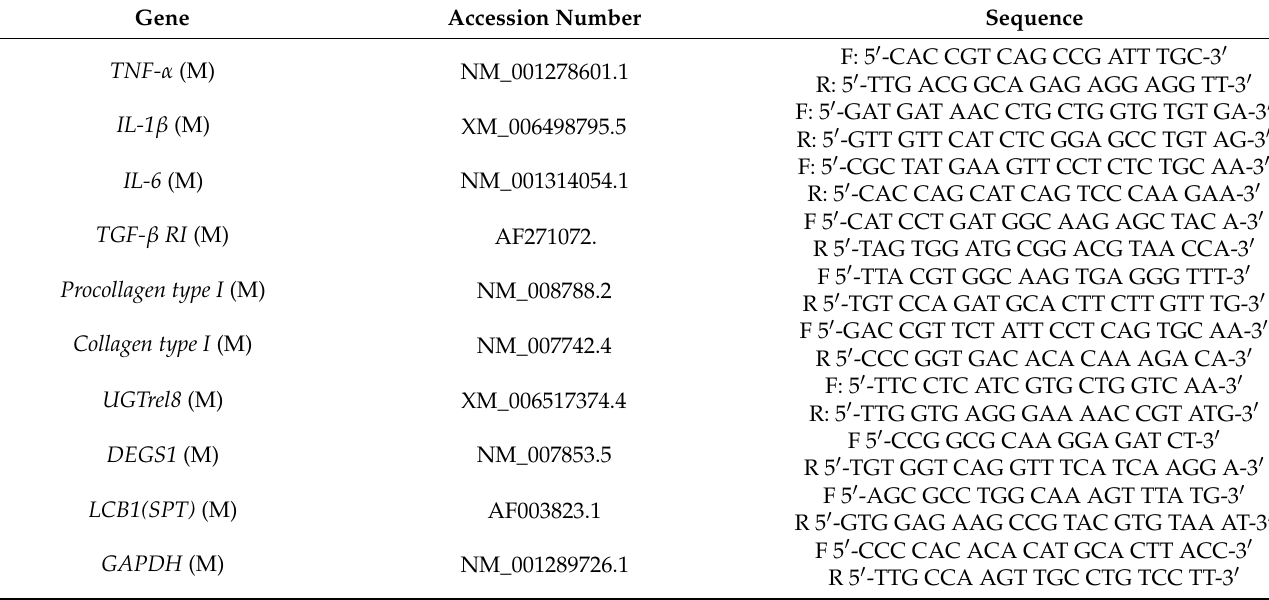
Table 1. Primer sets used for real-time